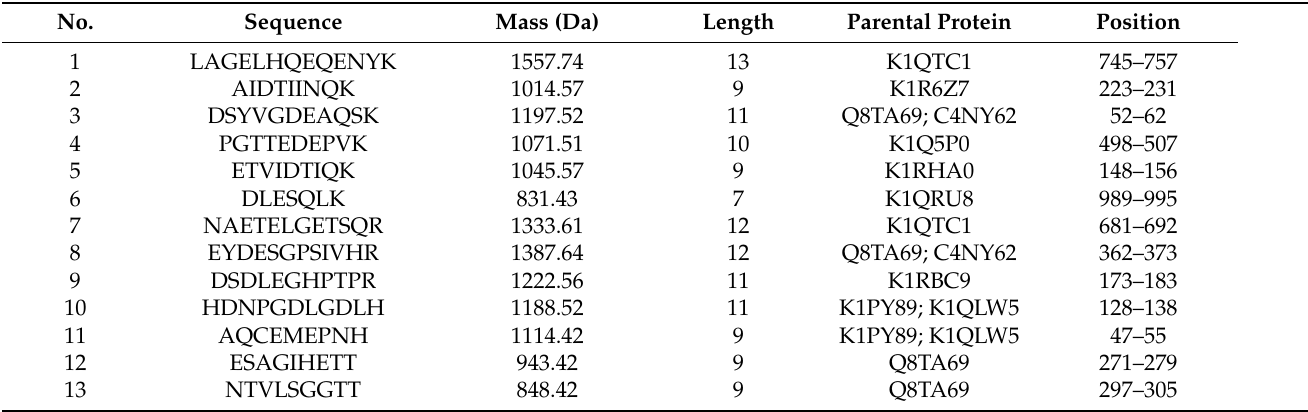
Table 3. The peptide sequences of